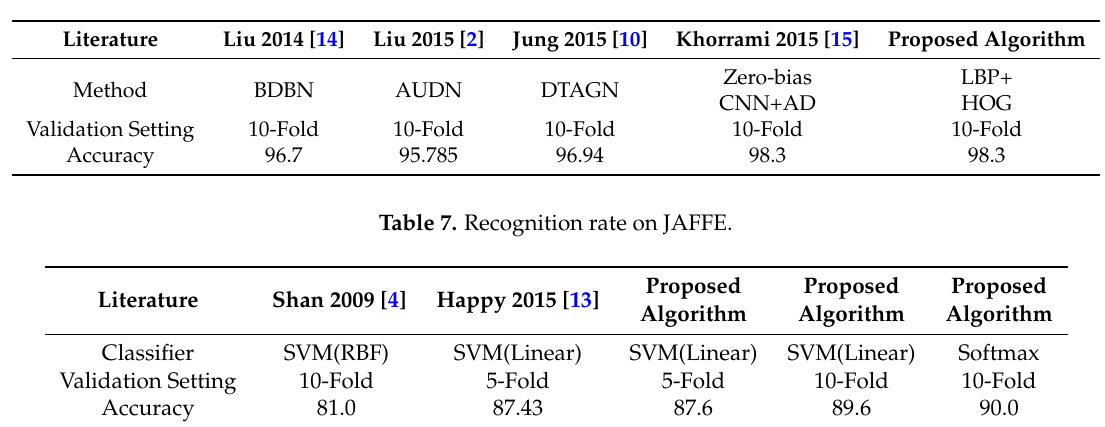
Table 6. Recognition rate on CK+.